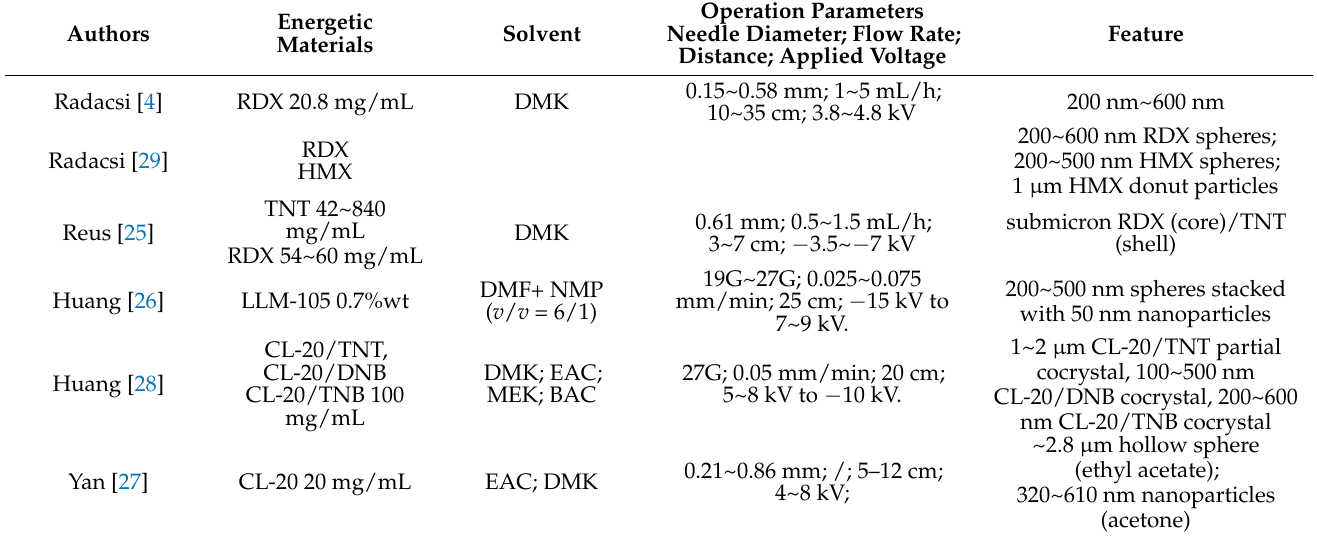
Table 1. Summary of organic explosives recrystallized and cocrystallized by